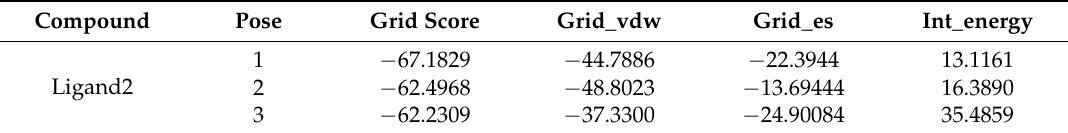
Table 3. Docking of ligand with receptor HDAC2 (unit: